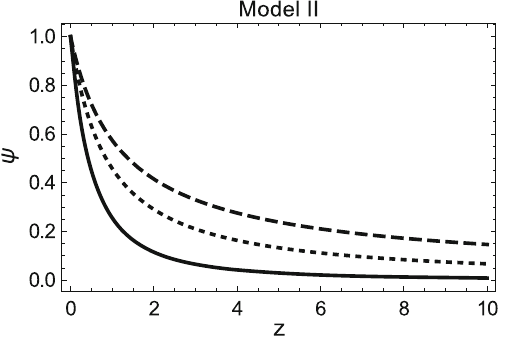
Fig. 2 Plotofthequintessencescalarfield ψ withredshiftforModel I I using different values of n . In the figure, n = − 0 . 01: black, n = − 0 . 2: black, dashed, n = − 0 . 5: black, dotted